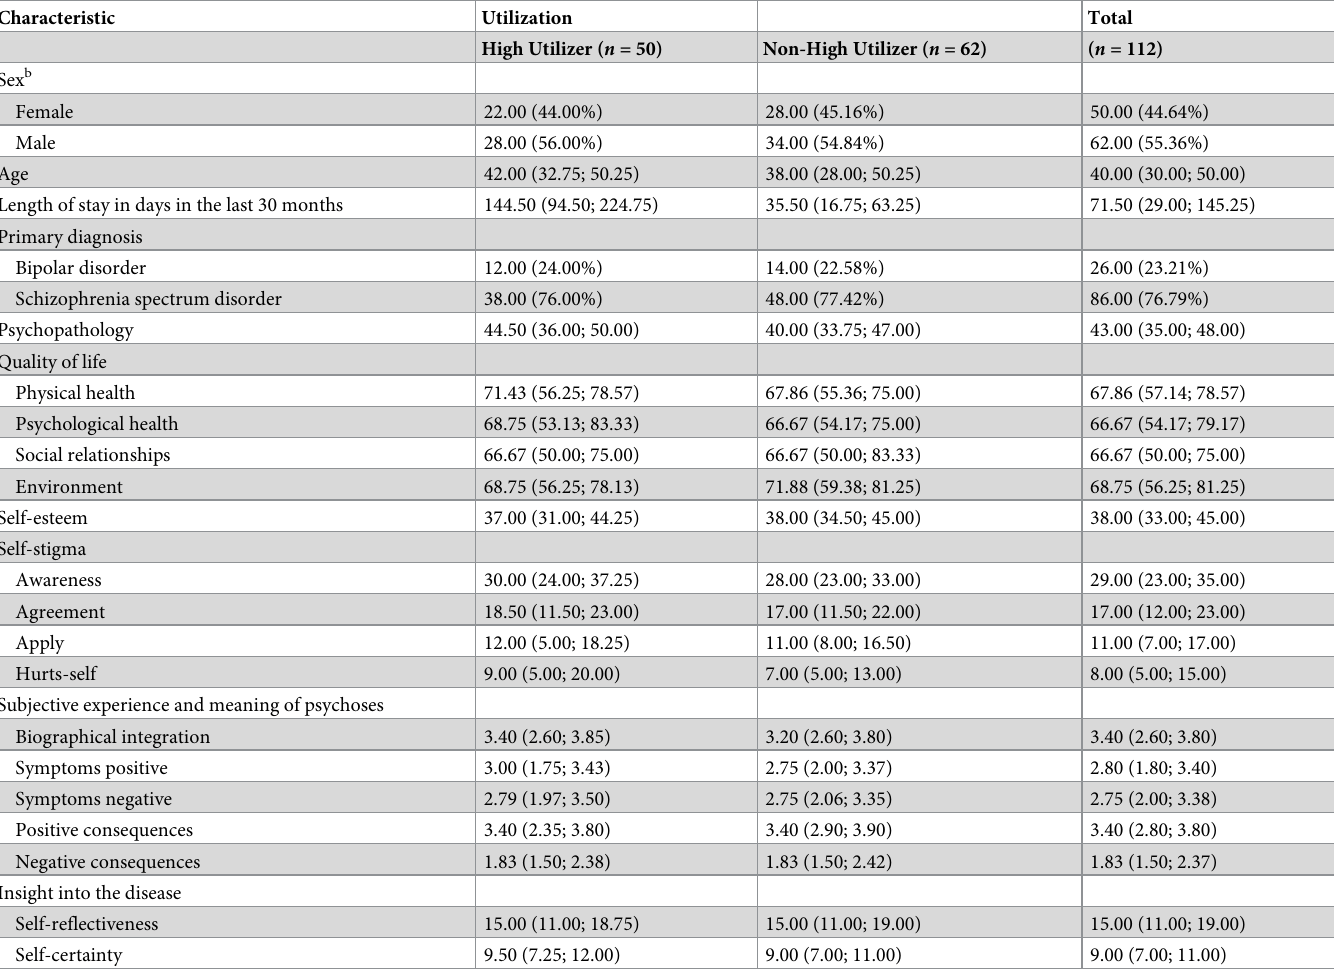
Table 1. Demographic, clinical, and psychological characteristics of High Utilizer and Non-High Utilizer patients and in the total sample a